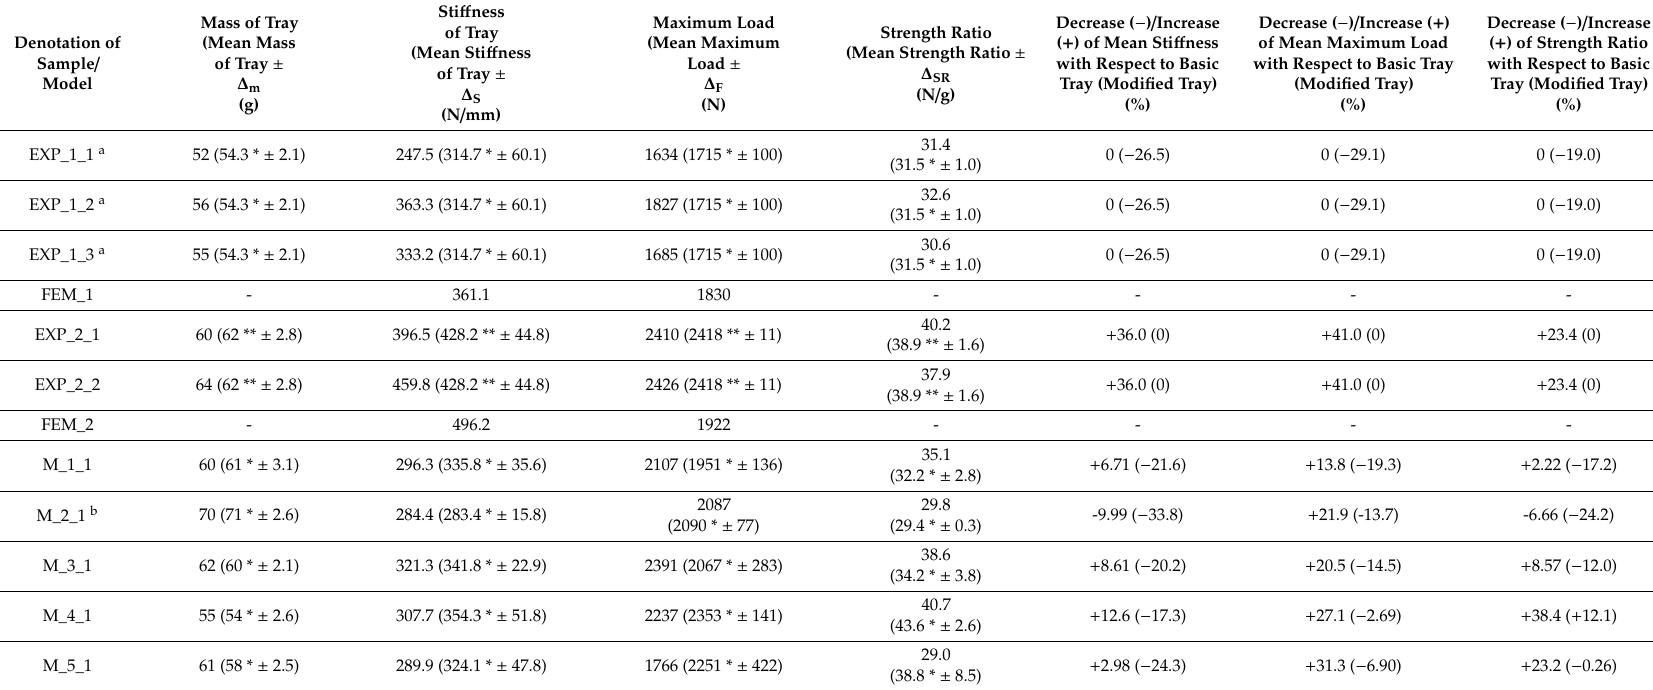
Table 1. Results of characteristic parameters (* average values for three specimens, ** average values for two